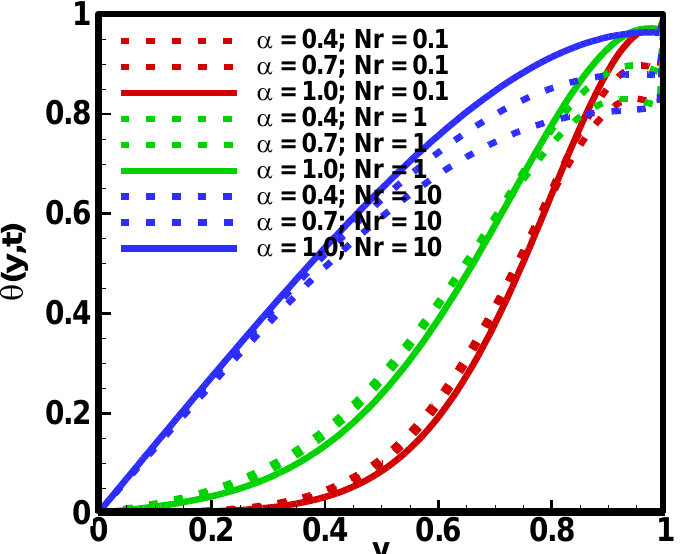
Figure 13. Influence of thermal radiation parameter 𝑁𝑟 on 𝜃(𝑦, 𝑡), when 𝜖 = 0.5, 𝐻𝑎 = 5, 𝑃𝑟 = 21, 𝑄 = 5, 𝜙 = 0.1.